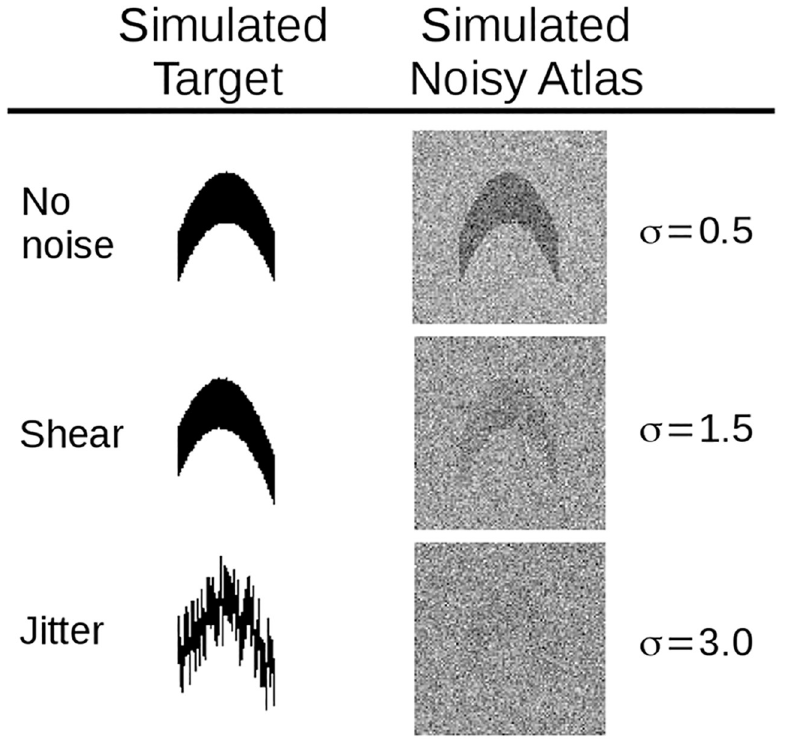
Fig 6. Simulated noise on a binary image phantom. Left column shows phantom for identity, shearing, and jitter of sections (successive rows); right column shows Gaussian white noise added to the atlas at various standard deviations.